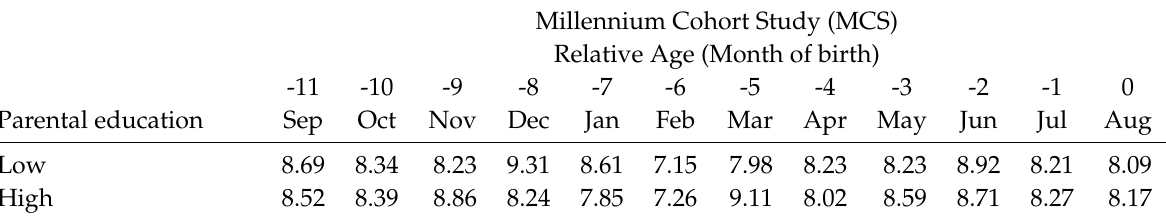
Table 2: Percentage of Children Born in Each Month by Parental